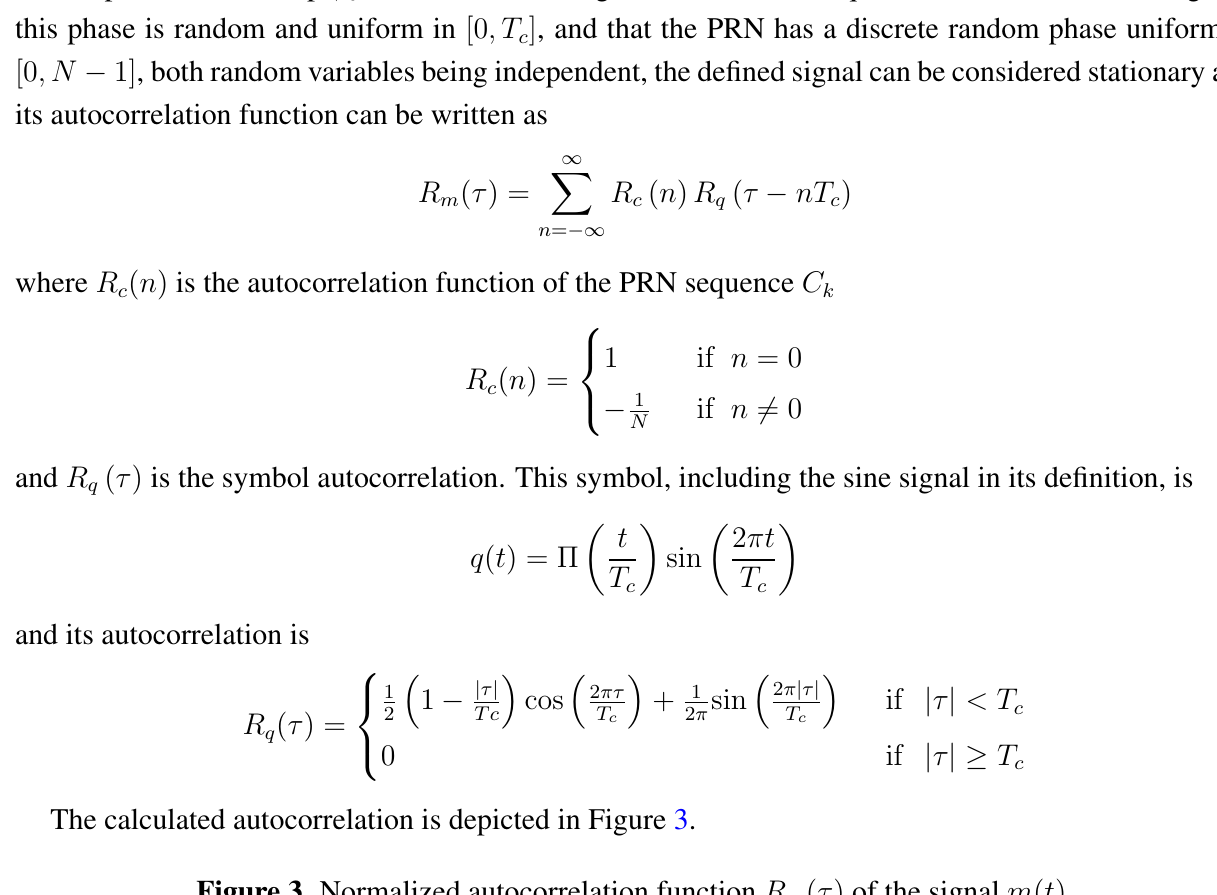
( τ ) of the signal m ( t ) m